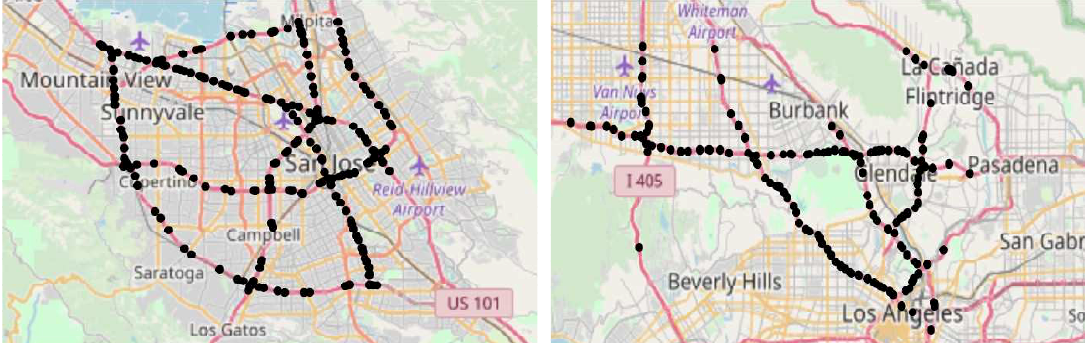
Figure 7. Sensor distribution of PeMSD4 and PeMSD7